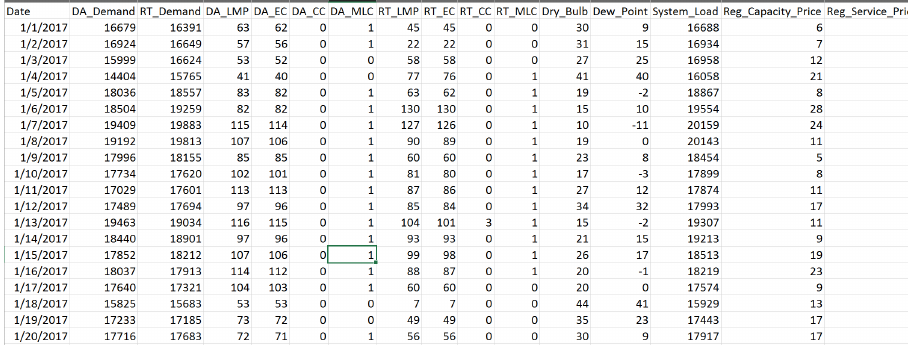
Figure 7. Dataset Overview.